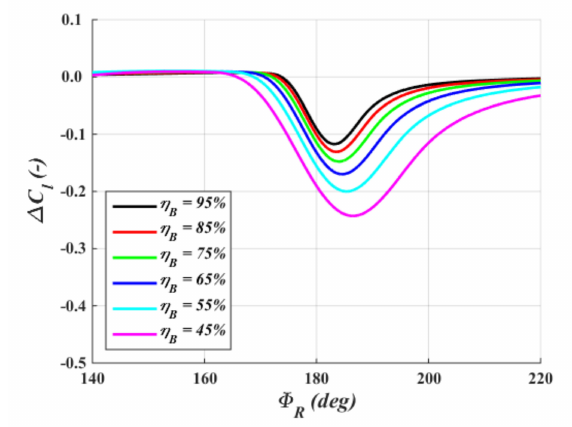
Figure 14. Deviations in lift coe ffi cient of the 300% model, C d = 1.2, V T = 36.0 m /